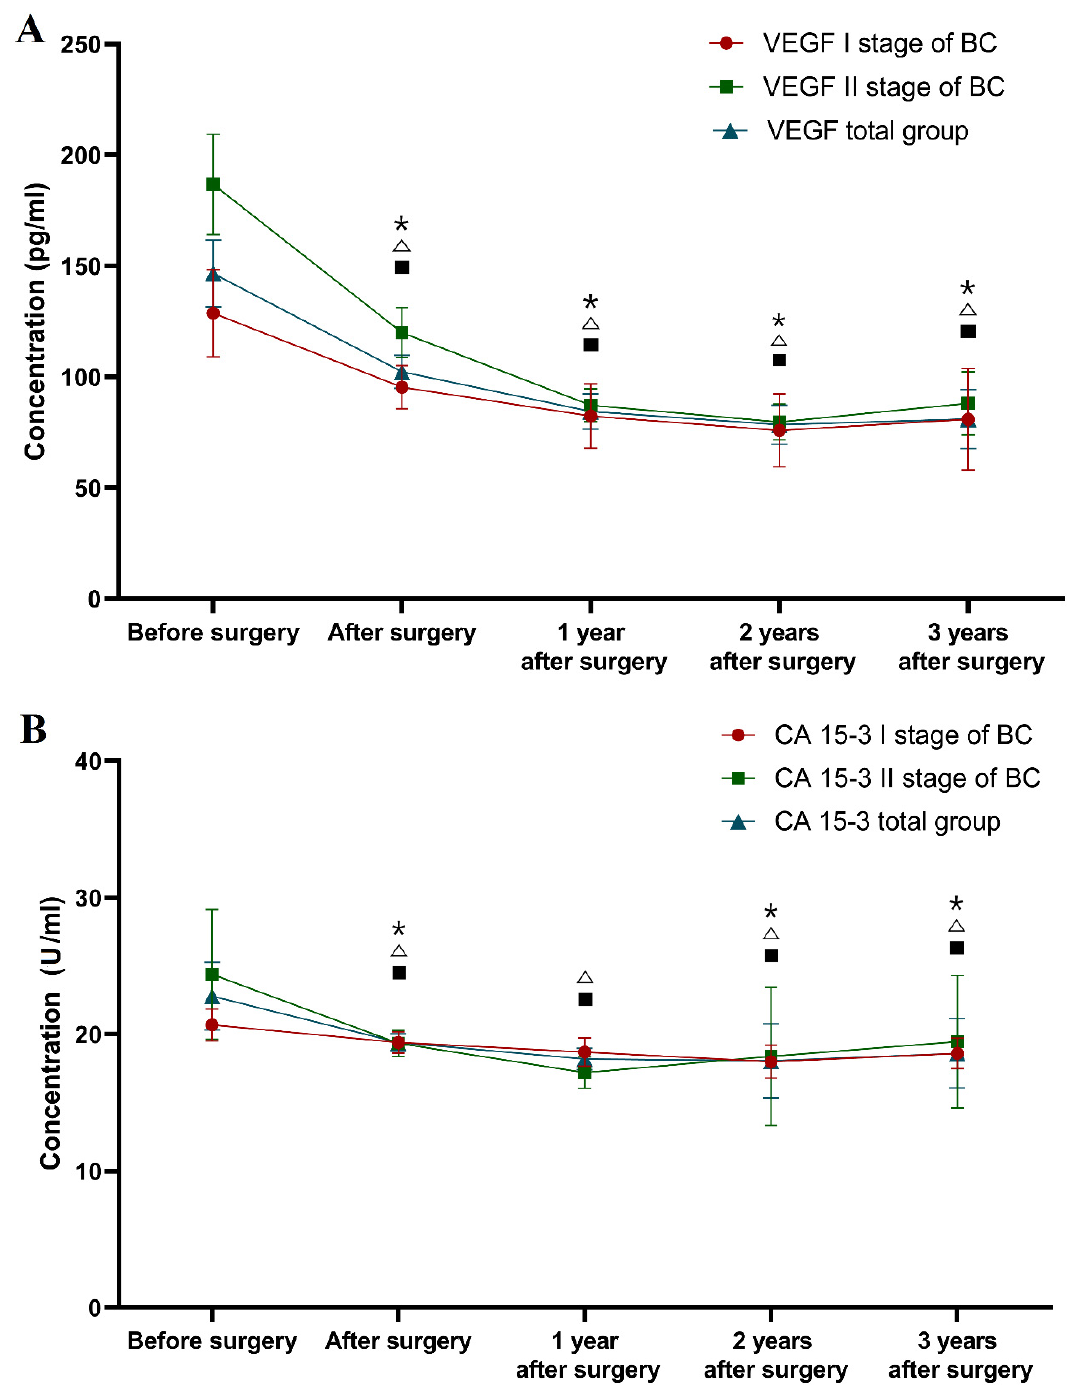
Figure 1. Plasma levels (median and standard error) of VEGF ( A ) and CA 15-3 ( B ) in a three-year follow-up of patients with breast cancer, according to the stage of tumor. * statistically significant difference from preoperative levels in BC stage I group, (cid:52) statistically significant difference from preoperative levels in BC stage II group, (cid:4) statistically significant difference from preoperative levels in BC total group.